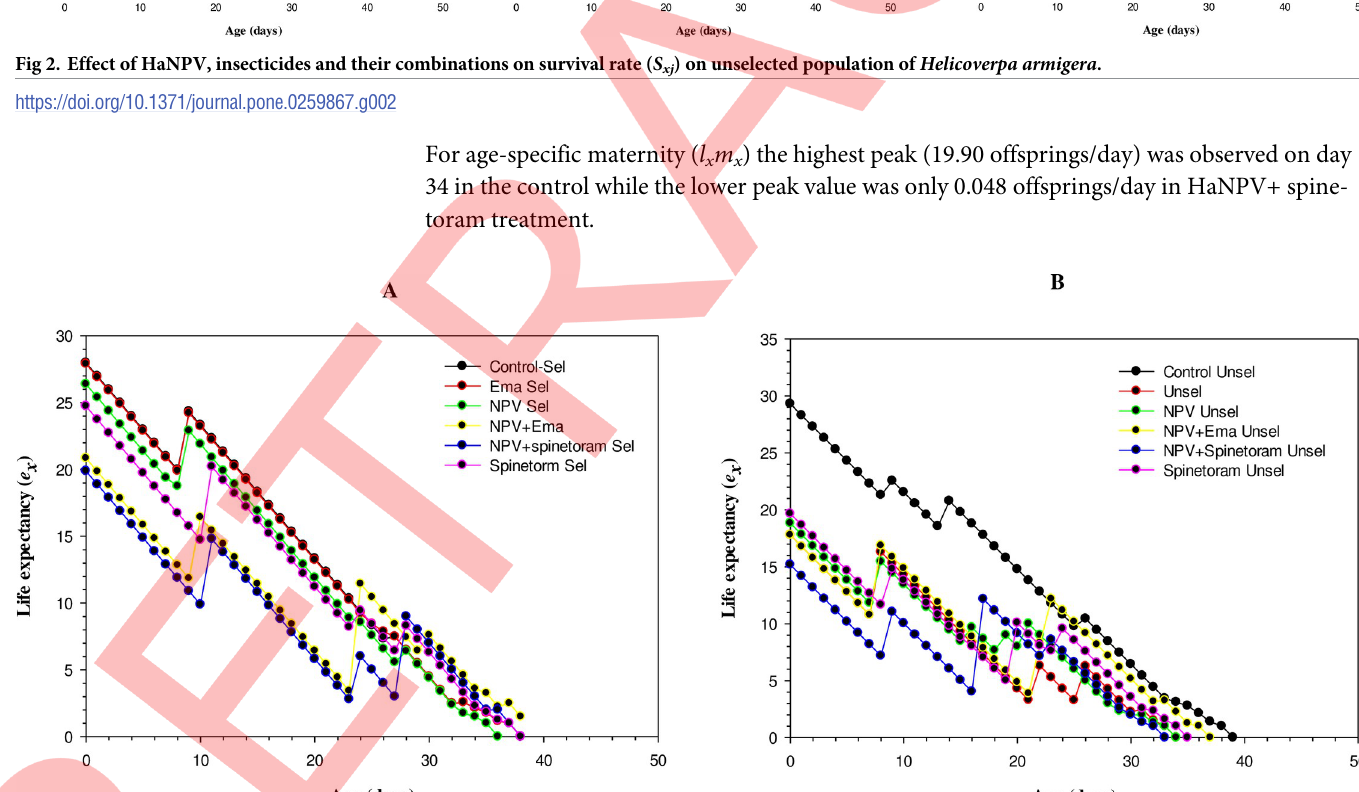
Fig 3. Effect of HaNPV, insecticides and their combinations on survival rate ( S Helicoverpa armigera